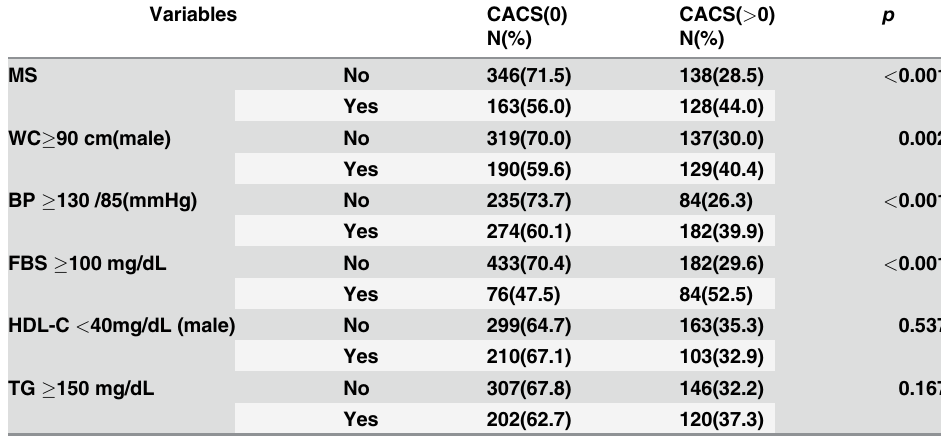
Table 2. Association between Metabolic Syndrome Components and CACS.